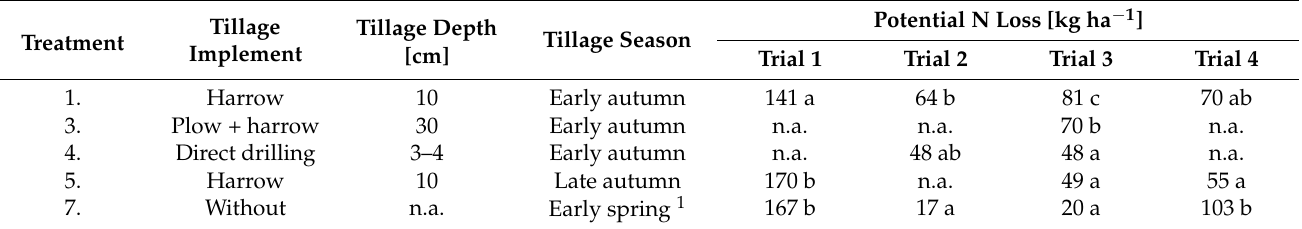
Table 3. Potential N losses according to the N balance sheet [N min (0–90 cm) at spinach harvest +